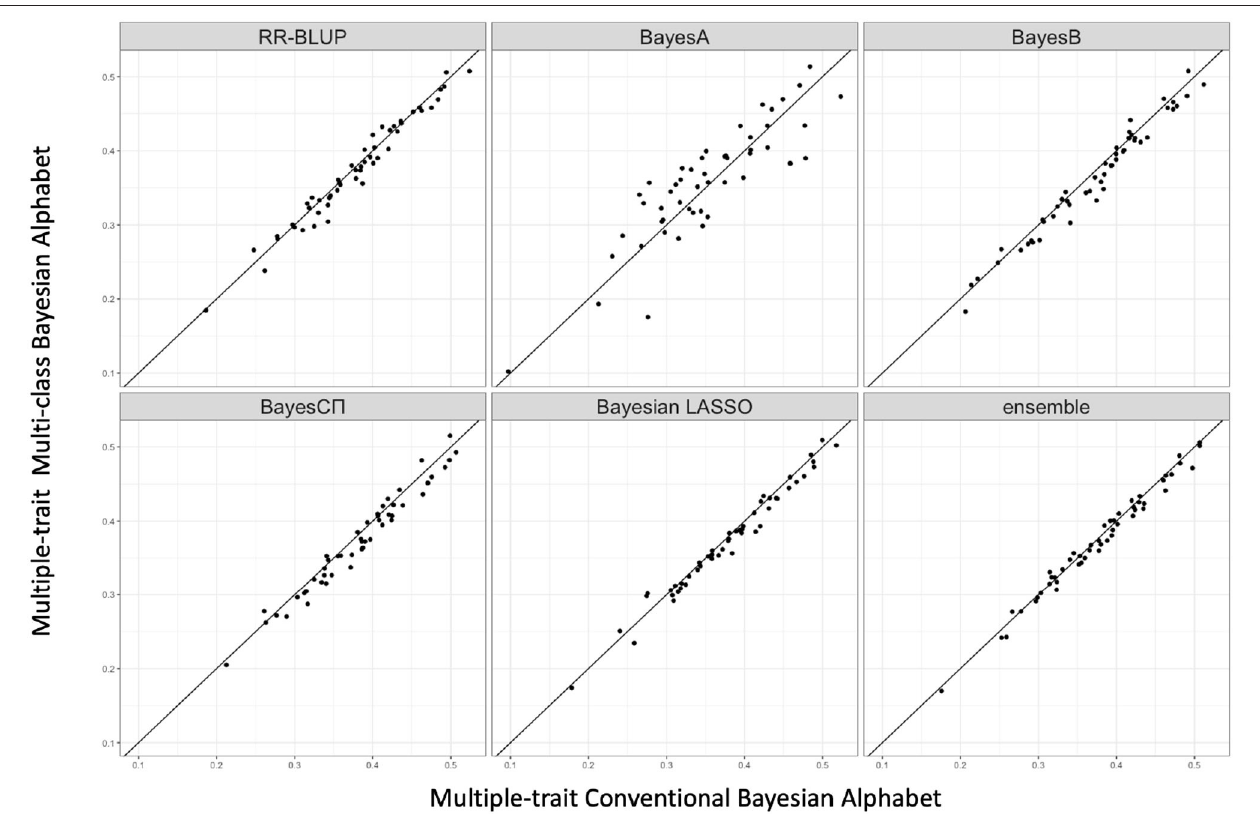
FIGURE 4 | The pairwise accuracy comparisons between conventional Bayesian method and multi-class Bayesian Alphabet using genome annotation classes for the trait FTA of rice real data. The x-axis represents the genomic prediction accuracy obtained from conventional Bayesian method; the y-axis represents the genomic prediction accuracy obtained from multi-class Bayesian Alphabet method; the diagonal line is used for reference such that a dot above the line represents a validation with higher accuracy for multi-class Bayesian Alphabet. No significant differences were found ( p < 0.1).